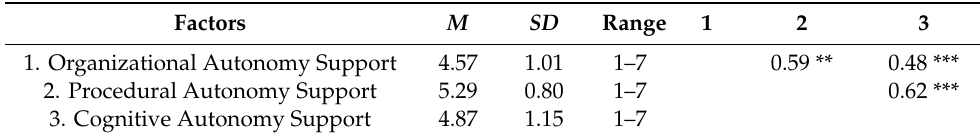
Table 2. Statistics and bivariate